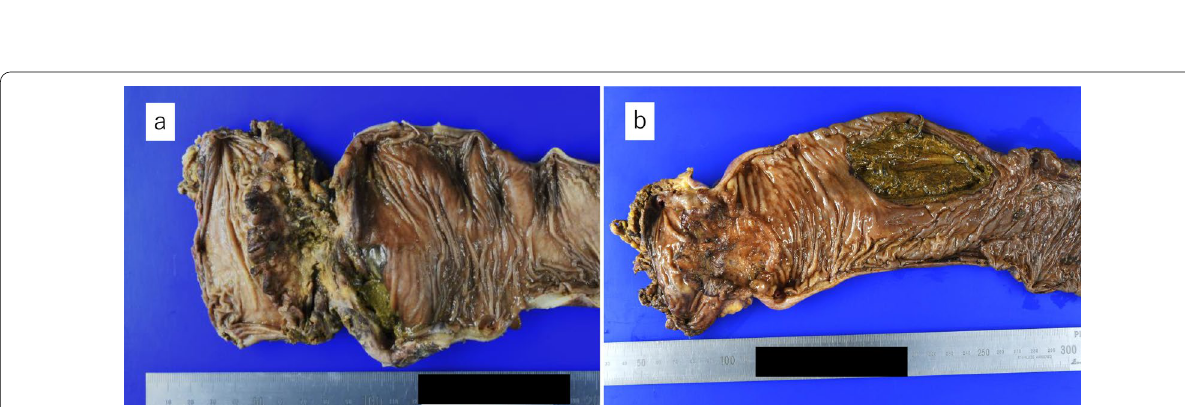
56 mm, well-differentiated adenocarcinoma (tub1), pT3, pN2 [5/16] and distal × 58 mm, well-differentiated adenocarcinoma (tub1), pT3, pN0 [0/13] and distal margin of ×